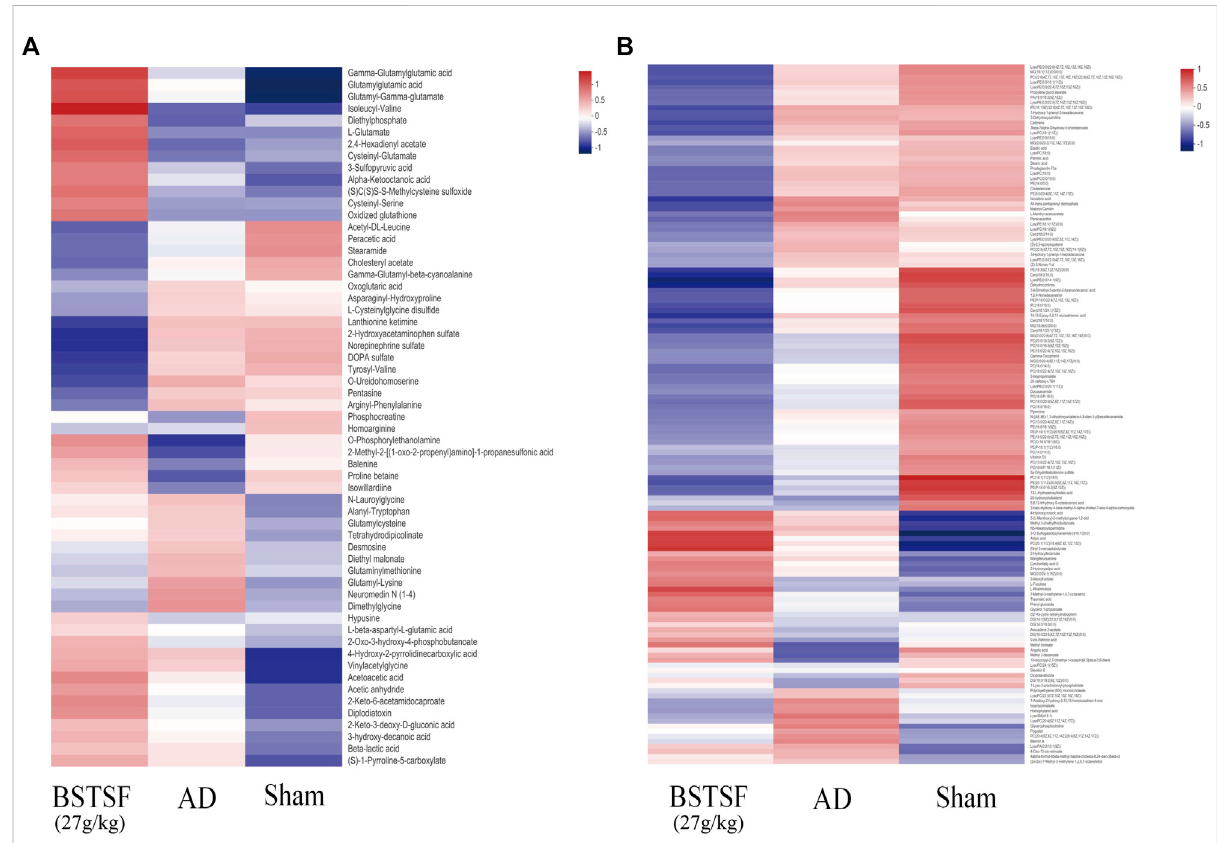
FIGURE 6 Heat map of differential metabolites in the hippocampus. (A) organic acid metabolites; (B) lipid